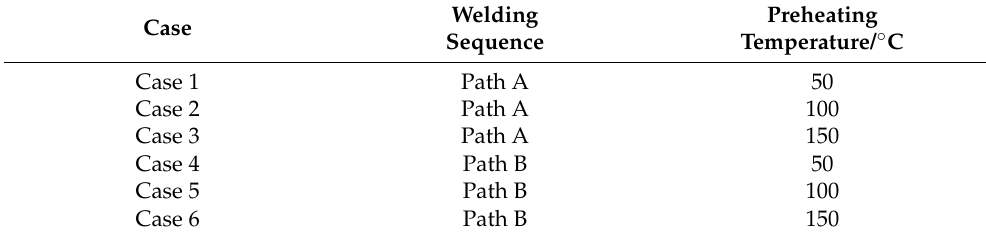
Figure 7. Two welding sequences.